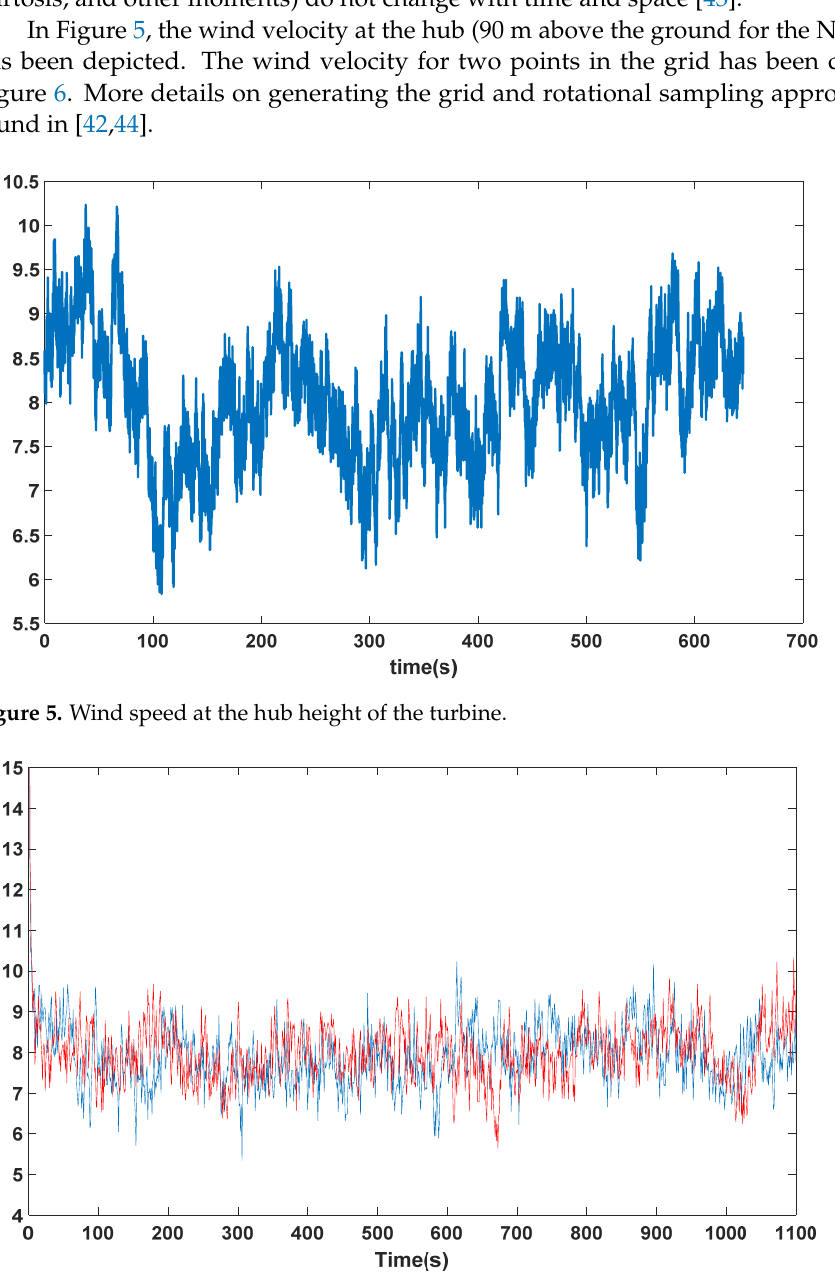
Figure 6. Wind speed at two different points in the grid with a distance of 10 m (blue and red are respectively the wind velocity at left and right points with the distance of 10 m).